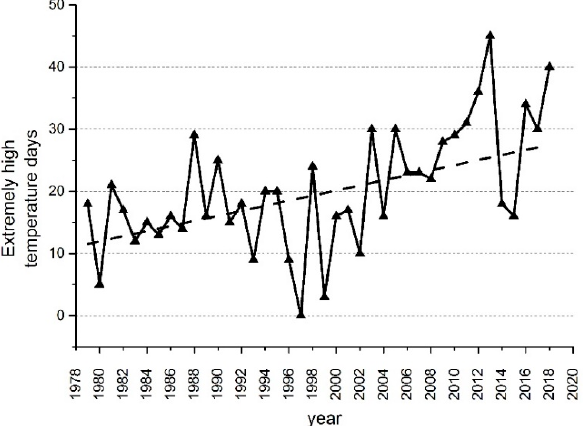
Figure 2. The number of days with temperature above 35 °C in Nanchang from 1979 to 2018. Air temperature data source: National meteorological information center.